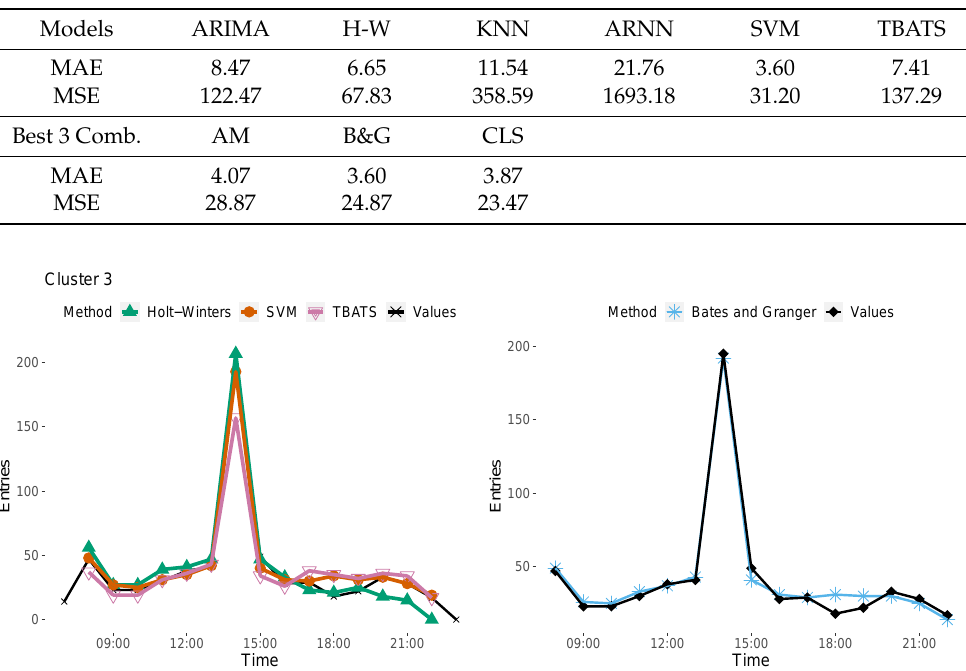
Figure 12. Cluster 3: two last days of historical data plus one-day predictions and real values ( left ). On the ( right ), a close-up of the predictions and real values is shown. Table 4. MAEs and MSEs for each model in Cluster 3 for one-week historical and one-day predictions, and for the different combinations of the best models.